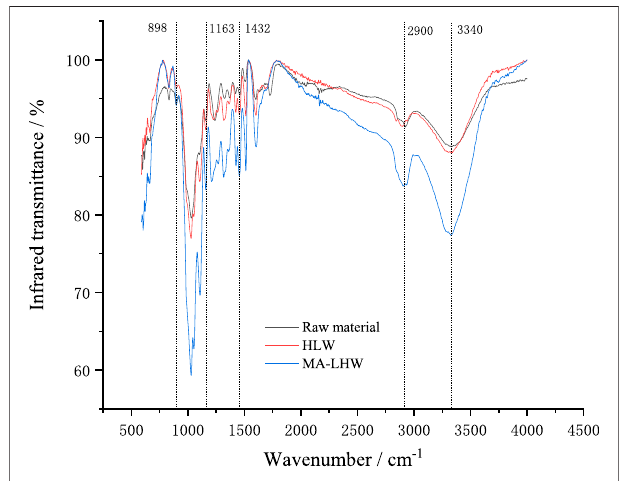
FIGURE 2 | Infrared spectroscopy of Moso bamboo pretreated by different methods.